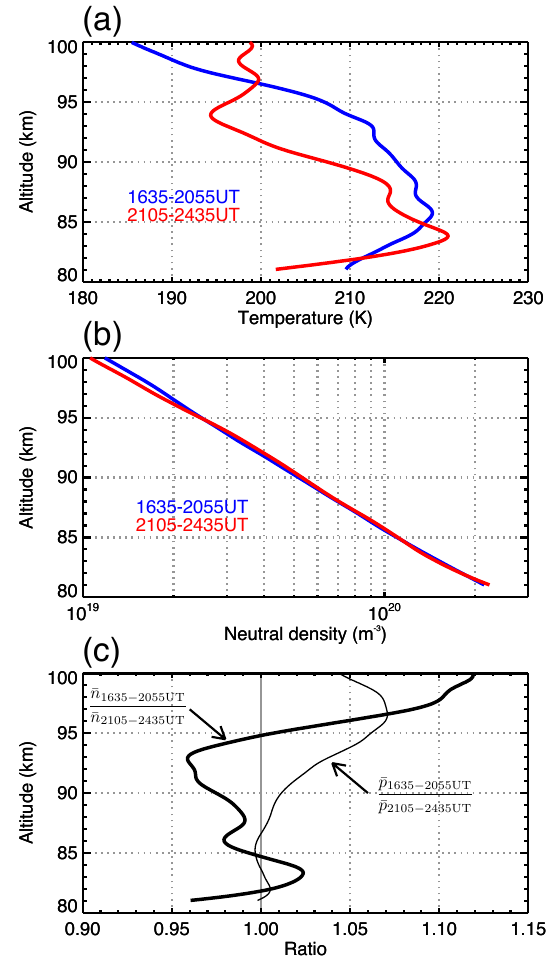
Figure 11. (a) Altitude profiles of the background temperature are compared for the two intervals between 16:30 and 21:00UT and 21:00 and 24:30UT. (b) Same as (a) but for the neutral density. (c) Ratios of neutral density (thick line) and pressure (thin line) be- tween the two